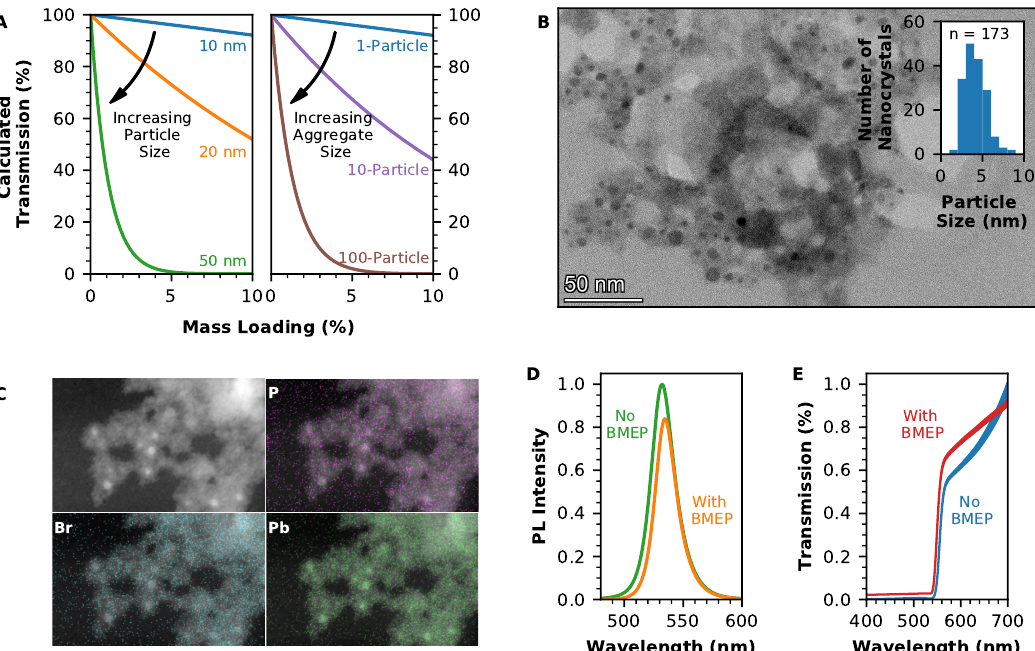
Figure 2. ( A ) Calculated effect of Mie scattering on transmission through a 1 mm-thick FAPbBr 3 /PVT composite as the nanocrystal loading is increased, either for various sizes of nanocrystal (left) or for aggregates of 10 nm particles (right). ( B ) High-resolution TEM image, showing FAPbBr 3 nanocrystals as dark features surrounded by the BMEP ligand. Inset shows the distribution of nanocrystal sizes, as measured from 173 nanocrystals. ( C ) High-angle annular dark field (HAADF) and EDS maps performed in scanning TEM mode, showing individual elemental maps for phosphorus (top right), bromine (bottom left), and lead (bottom right) in FAPbBr 3 nanocrystals with the BMEP surface ligand, overlaid on the HAADF image of of the nanocrystals (top left). ( D ) Photoluminescence of FAPbBr 3 nanocrystal dispersions either with (orange) or without (green) the BMEP ligand, showing a reduction in luminescence intensity when the BMEP ligand is used. ( E ) Transmission through the FAPbBr 3 /EJ-290 nanocomposite scintillator either with (red) or without (blue) the BMEP ligand, showing improved transmission when the BMEP ligand is